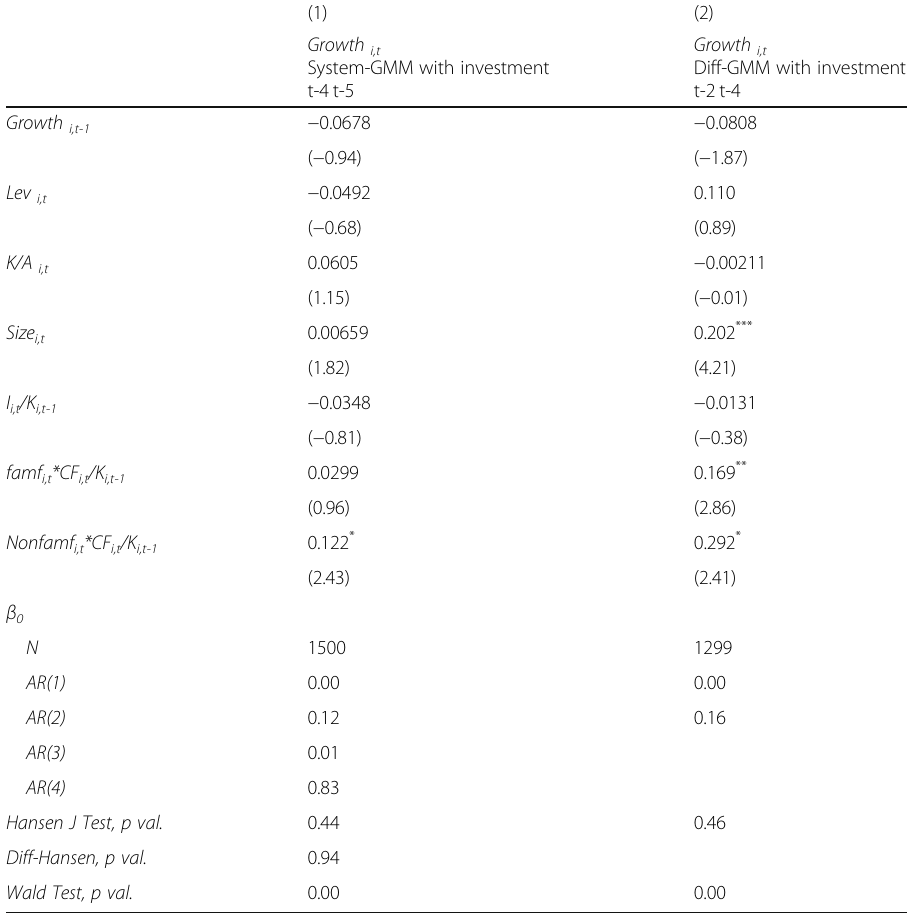
Table 9 The estimated models with